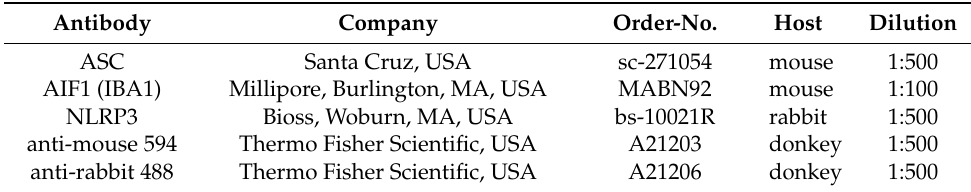
Table 3. List of antibodies used for immunofluorescence